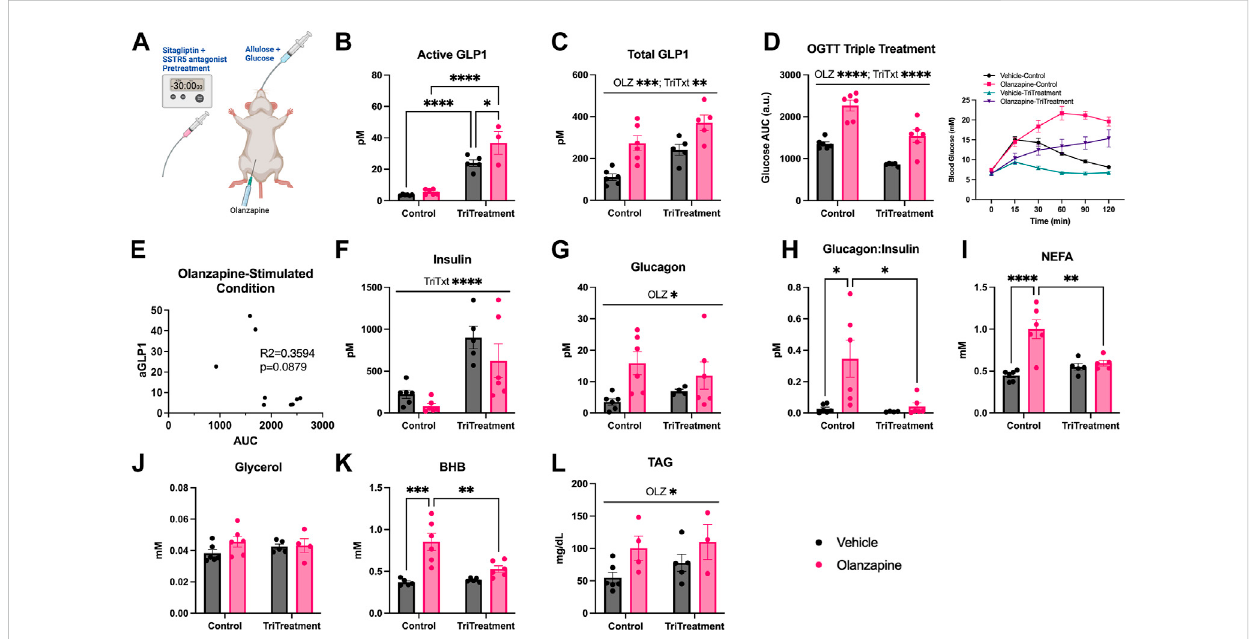
FIGURE 4 Triple treatment during OGTT improves olanzapine-induced changes in glucoseand lipid homeostasis. Mice were treated with a mixed oral gavage ofsitagliptin(10 mg/kg)andSSTR5antagonist(15 mg/kg)30 minpriortoamixedoralgavageofallulose(1 g/kg)andglucose(0.5 g/kg)andanIPinjection of olanzapine (5 mg/kg) (A) ( n = 4 – 6 mice/group). (B, C) Active and total GLP1 were measured from serum following 120 min from injection. (D) Blood glucose was measured from the distal tail blood and area under the curve (AUC) calculated. (E) A correlational analysis was performed between active GLP1 and bloodglucose AUC inolanzapine-treated animals.Inserum collected fromcardiac bloodinsulin (F) , glucagon (G) ,theratio ofglucagon: insulin (H) , Non-Esteri fi ed Fatty Acids (I) , glycerol (J) , Beta-Hydroxybutyrate (K) , and Triacylglycerol ( L ) were measured. Blood glucose AUC and serum hormones/metabolites wereanalyzed by two-way ANOVA. Lines over graphs indicate a main effect of thedescribed parameter while bars connected by linesindicateasigni fi cantdifferencebetweenindicatedgroups.* p < 0.05,** p < 0.01,*** p < 0.001,**** p < 0.0001.Alldataarepresentedasmean±SEM.